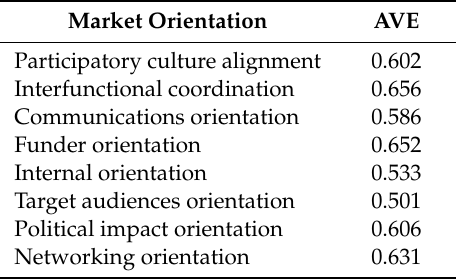
Table 6. Convergent validity of the first-order model.